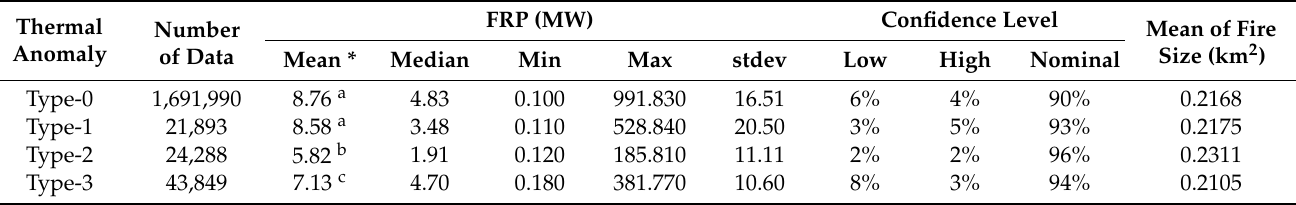
Table 2. The statistical values of FRP and the Tukey test results of the mean FRP at each type of thermal anomaly. * The same and different superscript letter in the mean values of FRP represent no significant difference and significant difference, respectively, at the confidence level of 95%. The percentage of the VNP14IMGML were counted for each confidence level (low, high, and nominal) in the period of 2012 to 2020.